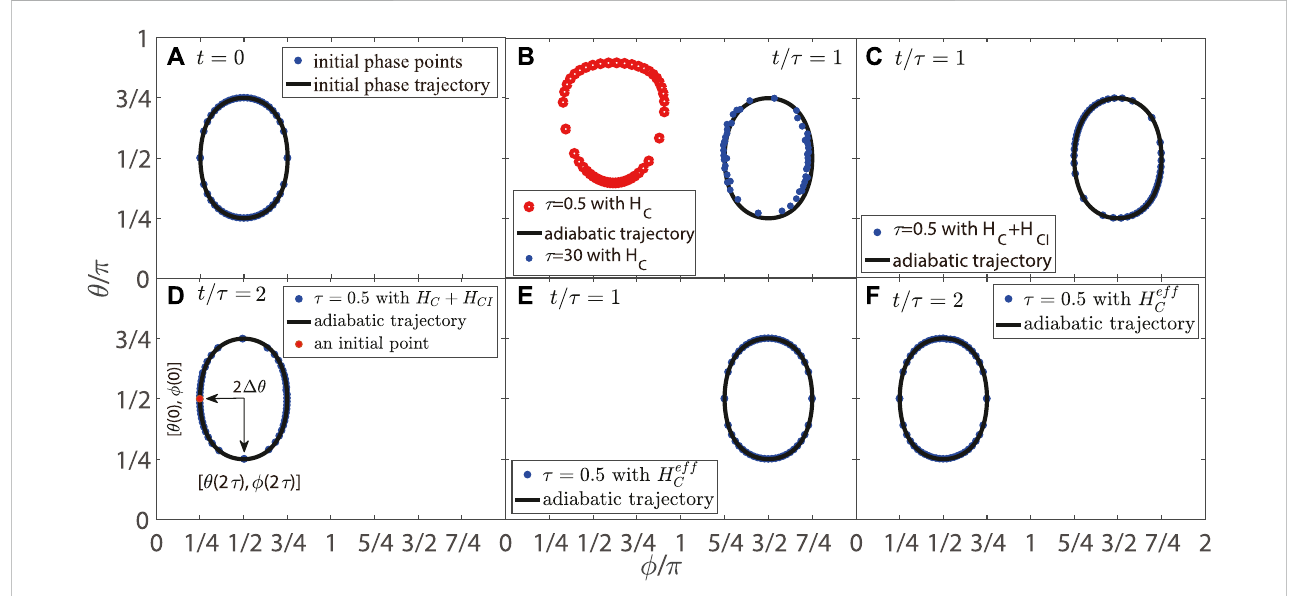
FIGURE 1 (A) Initialphasetrajectory(solidline)andinitialphasepoints(bluedots). (B) Finaladiabatictrajectory(solidline)and fi nalphasepointsdrivenby H C when t / τ =1, τ =.5(reddotblanks)and τ =30(bluedots). (C) Finaladiabatictrajectory(solidline)and fi nalphasepointsdrivenby H C + H CI ,when t / τ =1and τ =.5(blue dots). (D) Final adiabatic trajectory (solid line) and fi nal phase points driven by H C + H CI , when t / τ = 2 and τ = .5 (blue dots). (E) Final adiabatic trajectory (solid line) and fi nal phase points driven by H eff I , when t / τ = 1 and τ = .5 (blue dots). (F) Final adiabatic trajectory (solid line) and fi nal phase points driven by H eff I , when t / τ = 2 and τ = .5 (blue